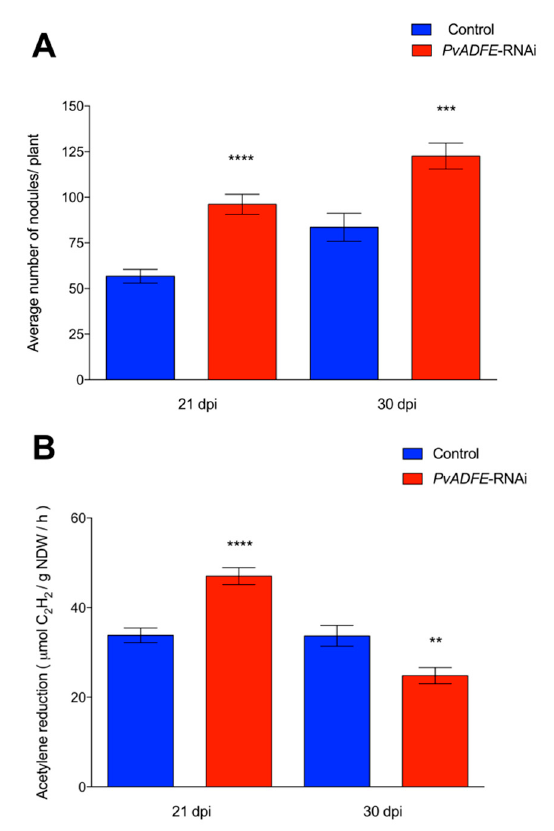
Figure 4. Nodulation and nitrogen fixation capacity of PvADFE -RNAi and control transgenic roots. ( A ) Nodules were collected and counted from control and PvADFE -RNAi transgenic roots inoculated with R. tropici CIAT-899 at 21 and 30 dpi. ( B ) Nitrogenase activity determined by acetylene reduction in control and PvADFE -RNAi nodules of transgenic roots at 21 and 30 dpi. NDW: Nodule dry weight. Bars represent mean ± SEM for three biological replicates with n > 7. ** p < 0.005, *** p < 0.0005, and **** p < 0.0001 based on Student’s t- test.